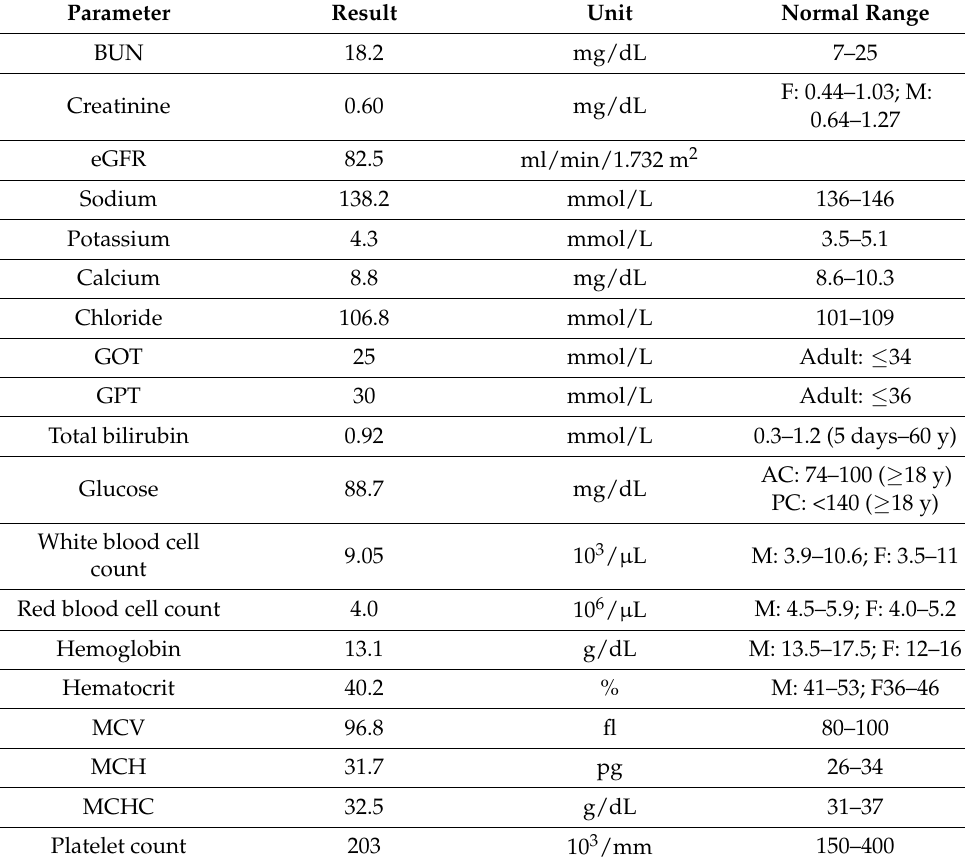
Figure 1. ( a ) Erythematous rash over the left upper arm two days after receiving the mRNA-1273 vaccine. ( b ) The arm four days later after antihistamine treatment. Table 1. Results of blood biochemistry tests and complete blood cell counts.